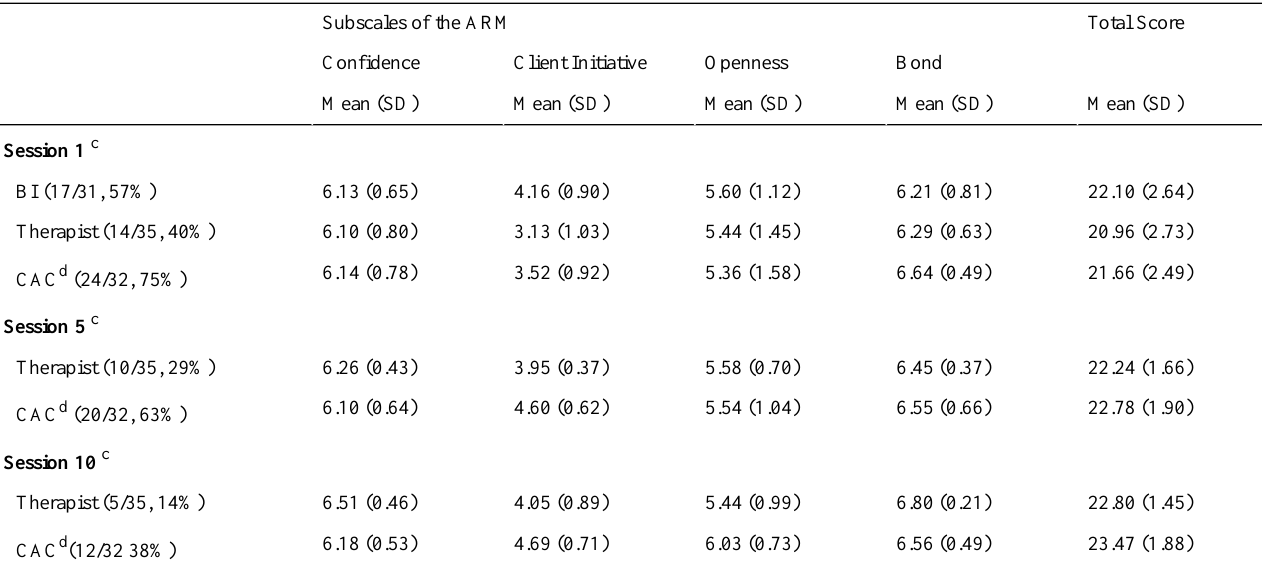
Total ScoreSubscales of the ARM